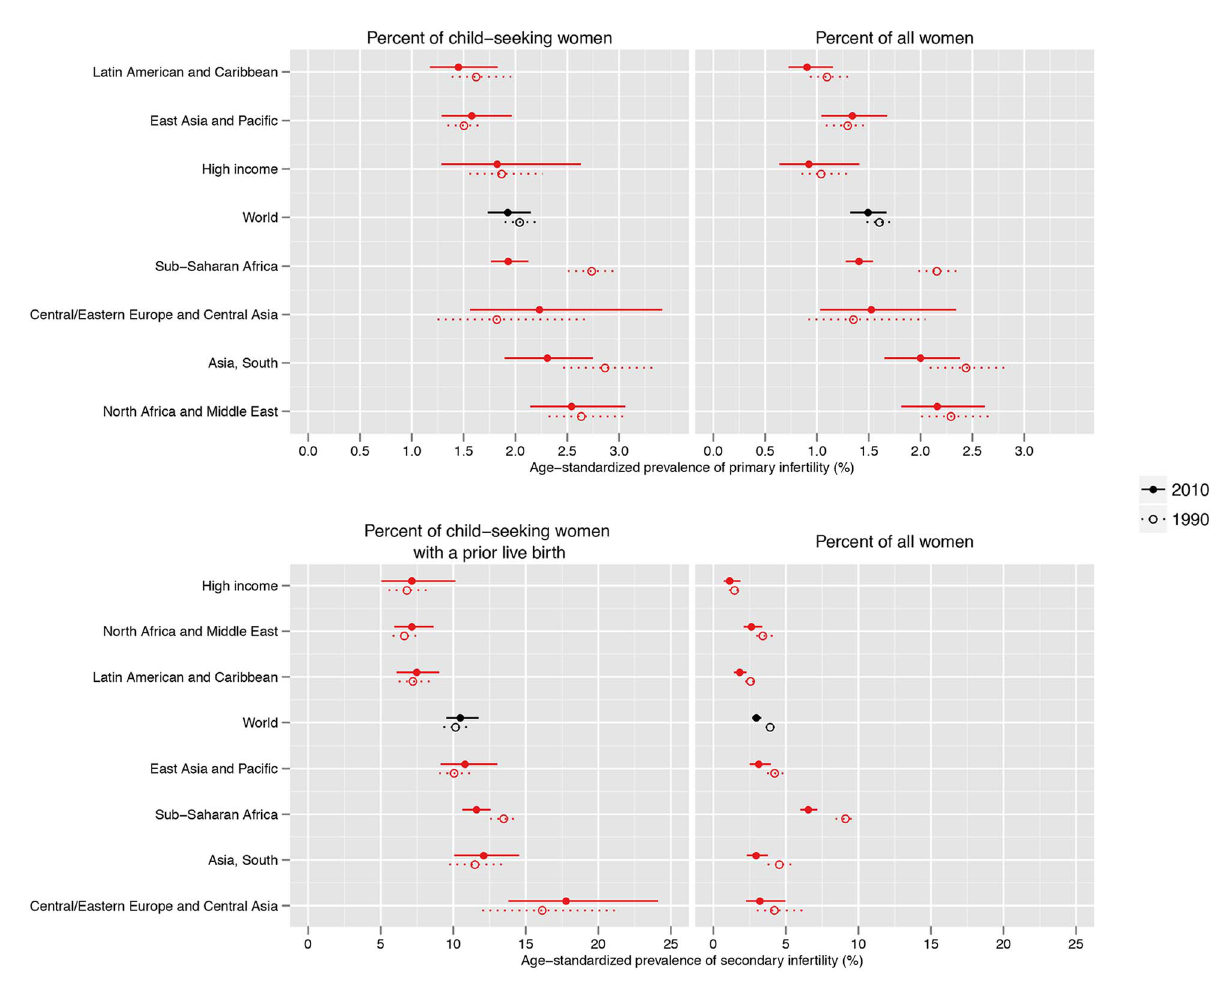
Figure 2. Prevalence of primary infertility and secondary infertility, presented as the percent of women who seek a child, and as the percent of all women of reproductive age, in 1990 and 2010. Infertility prevalence is indexed on the female partner; age-standardized prevalence among women aged 20–44 y is shown here. Horizontal lines indicate the 95% uncertainty interval.